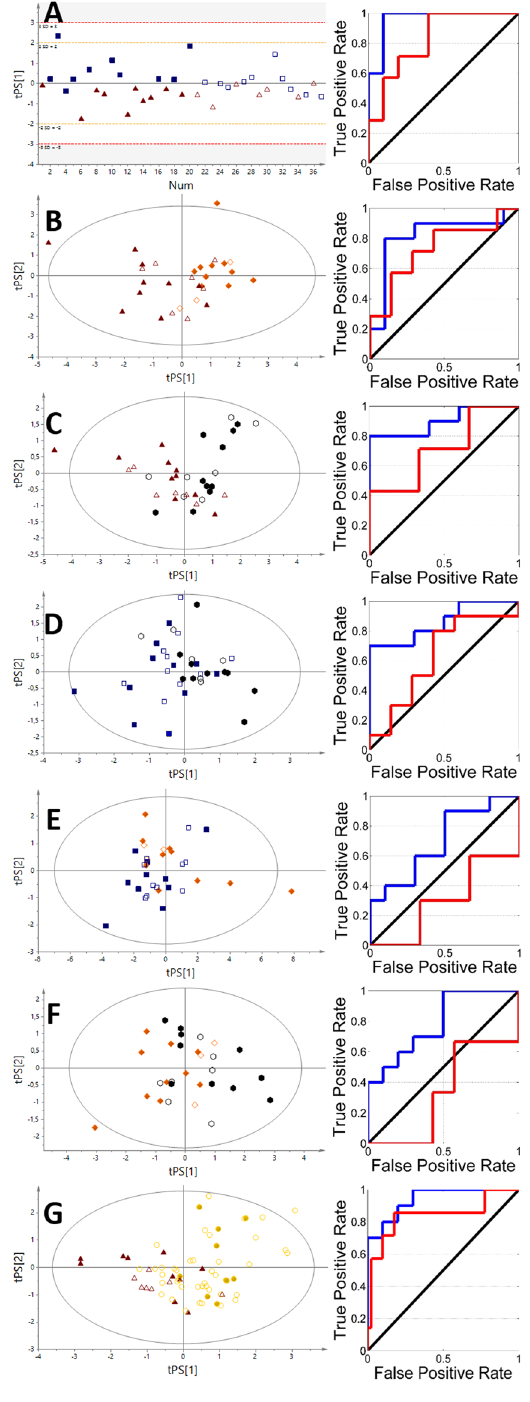
Figure 3. The VIP-PLS-DA models and ROC curves obtained from serum samples. ( A) – NN vs HC; ( B) – FA vs HC; ( C) – TC vs HC; ( D) – TC vs NN; ( E) – FA vs NN; ( F) – FA vs TC; ( G) – P vs HC. Red triangles – healthy control; blue boxes – non-neoplastic nodules; yellow diamonds – follicular adenoma; black hexagons – papillary thyroid cancer; gold circles – patients. Solid symbols: training set; empty symbols: predicted test